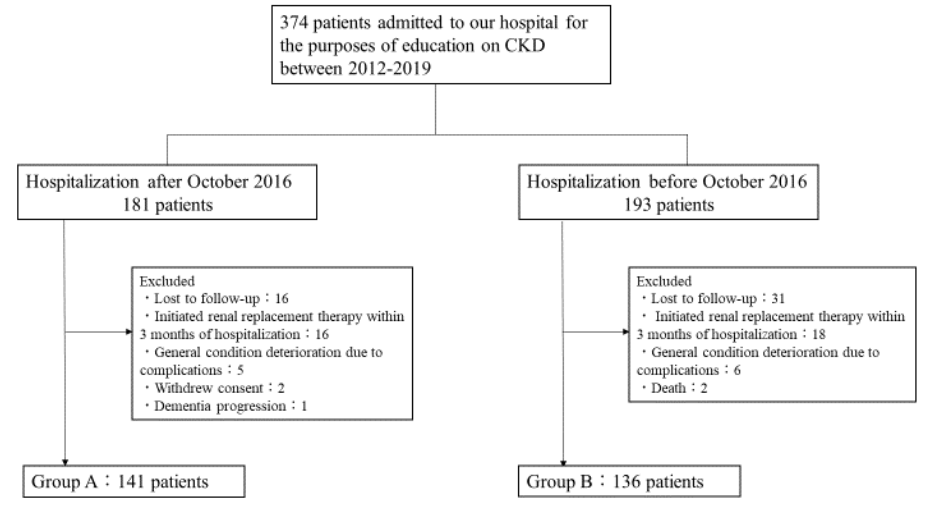
Figure 1. Flow chart of patients in the study groups.